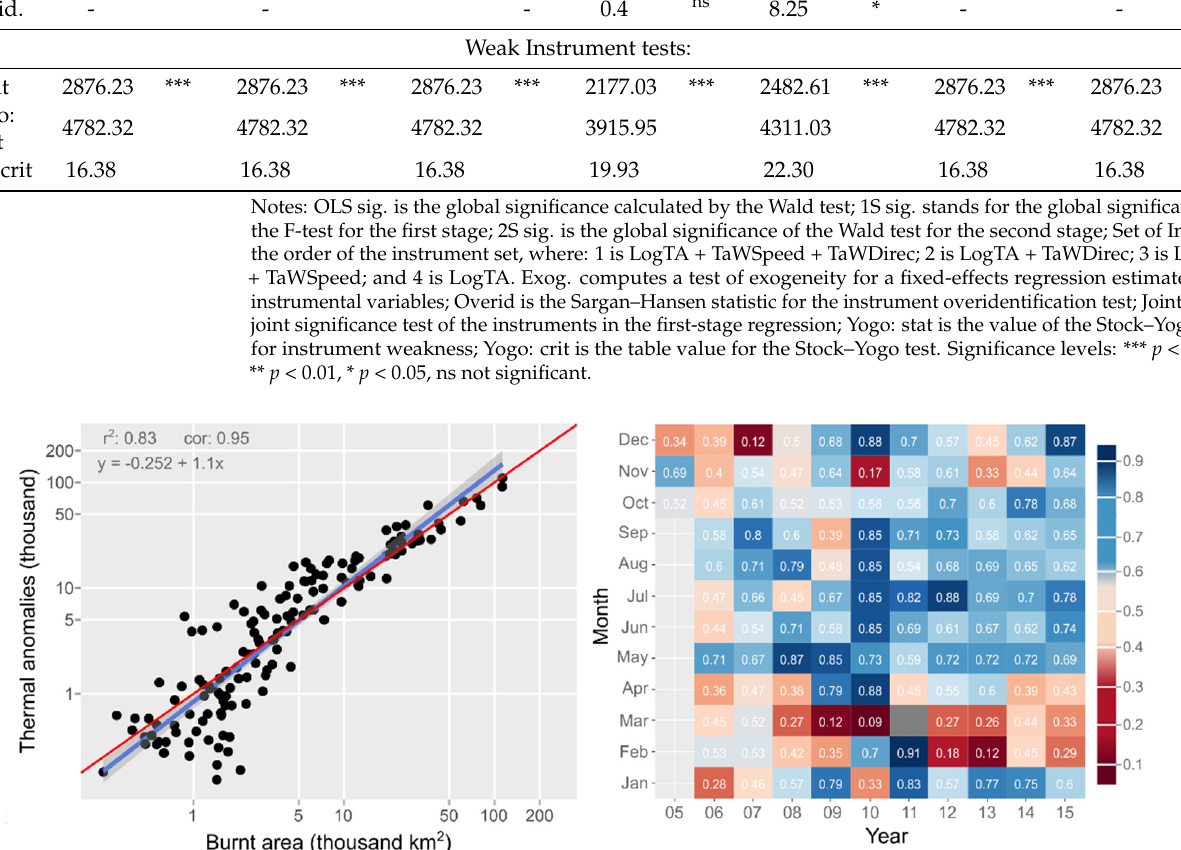
Figure 7. Correlation of monthly values of thermal anomalies and burned area, for all time series and months.